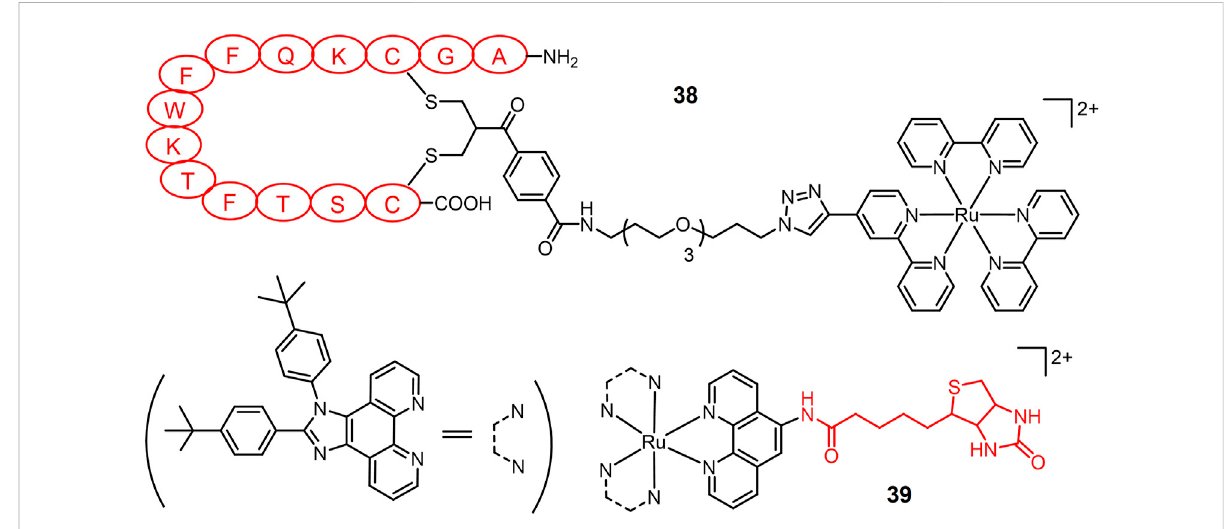
FIGURE 9 Light-responsive Ru(II) prodrugs bearing receptor-binding ligands as cancer selective photosensitizers for